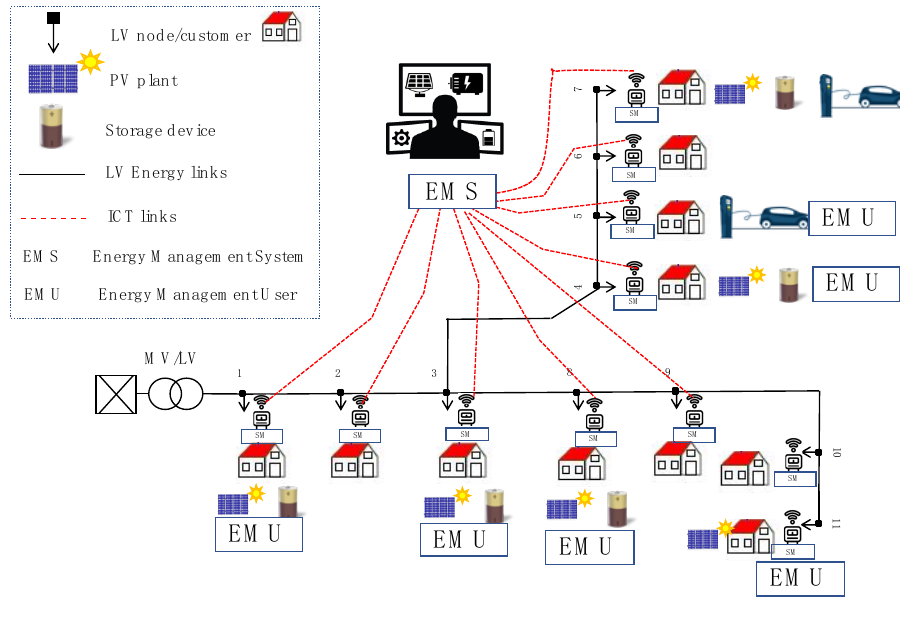
Figure 4. Future LV distribution grid.